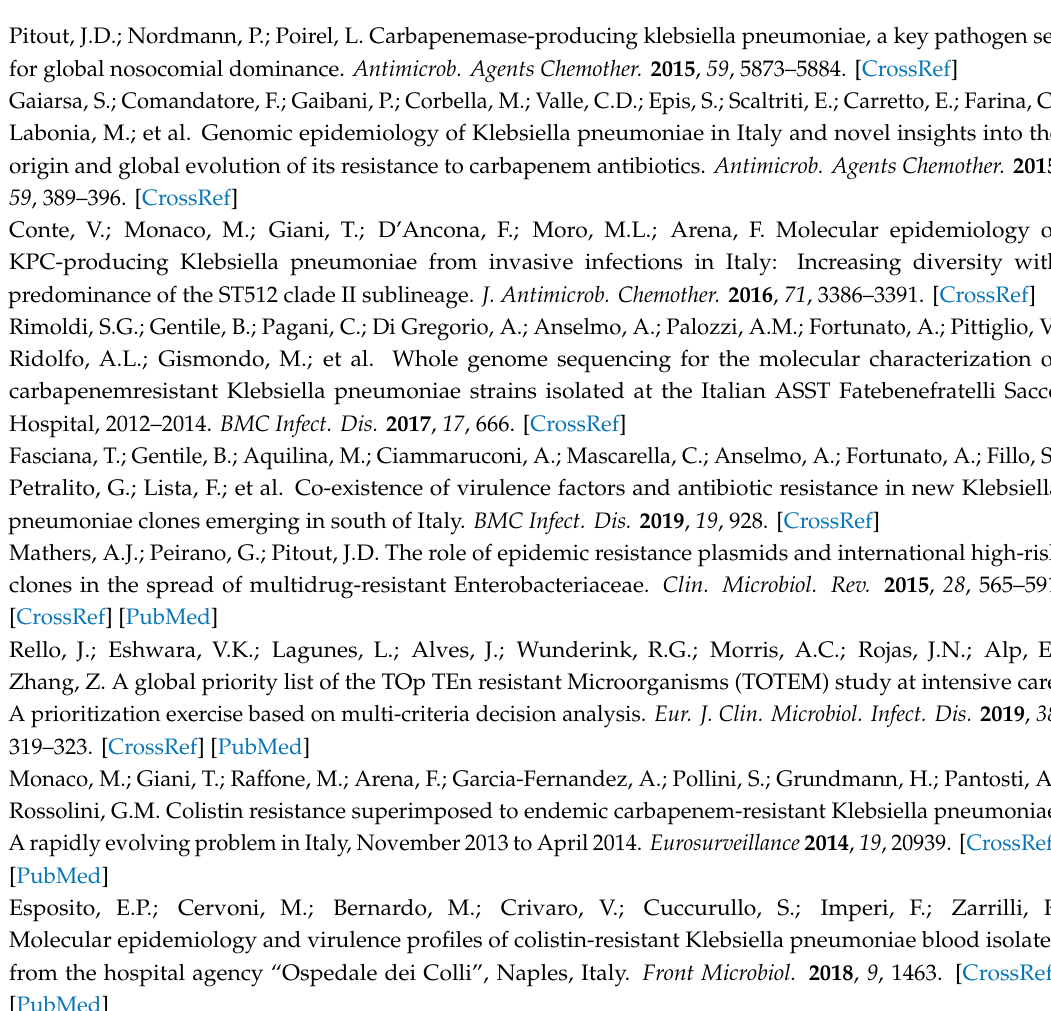
Supplementary Table S1: MICs ( µ g / mL) of antimicrobial agents for CRCR- Kp. Supplementary Table S2: The assembly statistics for each